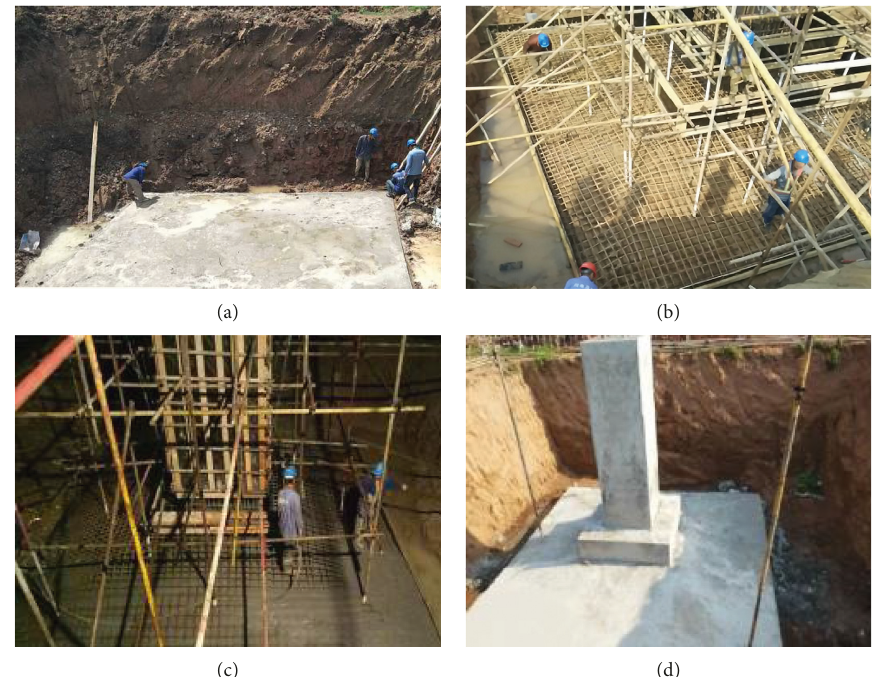
Figure 19: Construction process of the engineering case. (a) Ground construction. (b) Reinforcement construction. (c) Concrete con- struction. (d) Foundation after stripping.